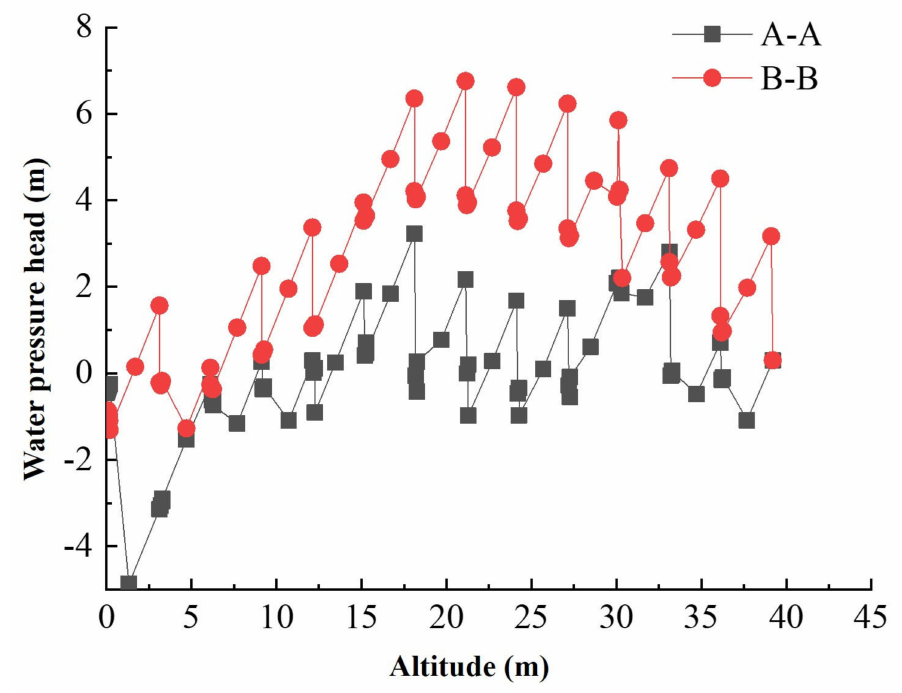
Figure 10. Water pressure head variation with daily cover (10 − 6